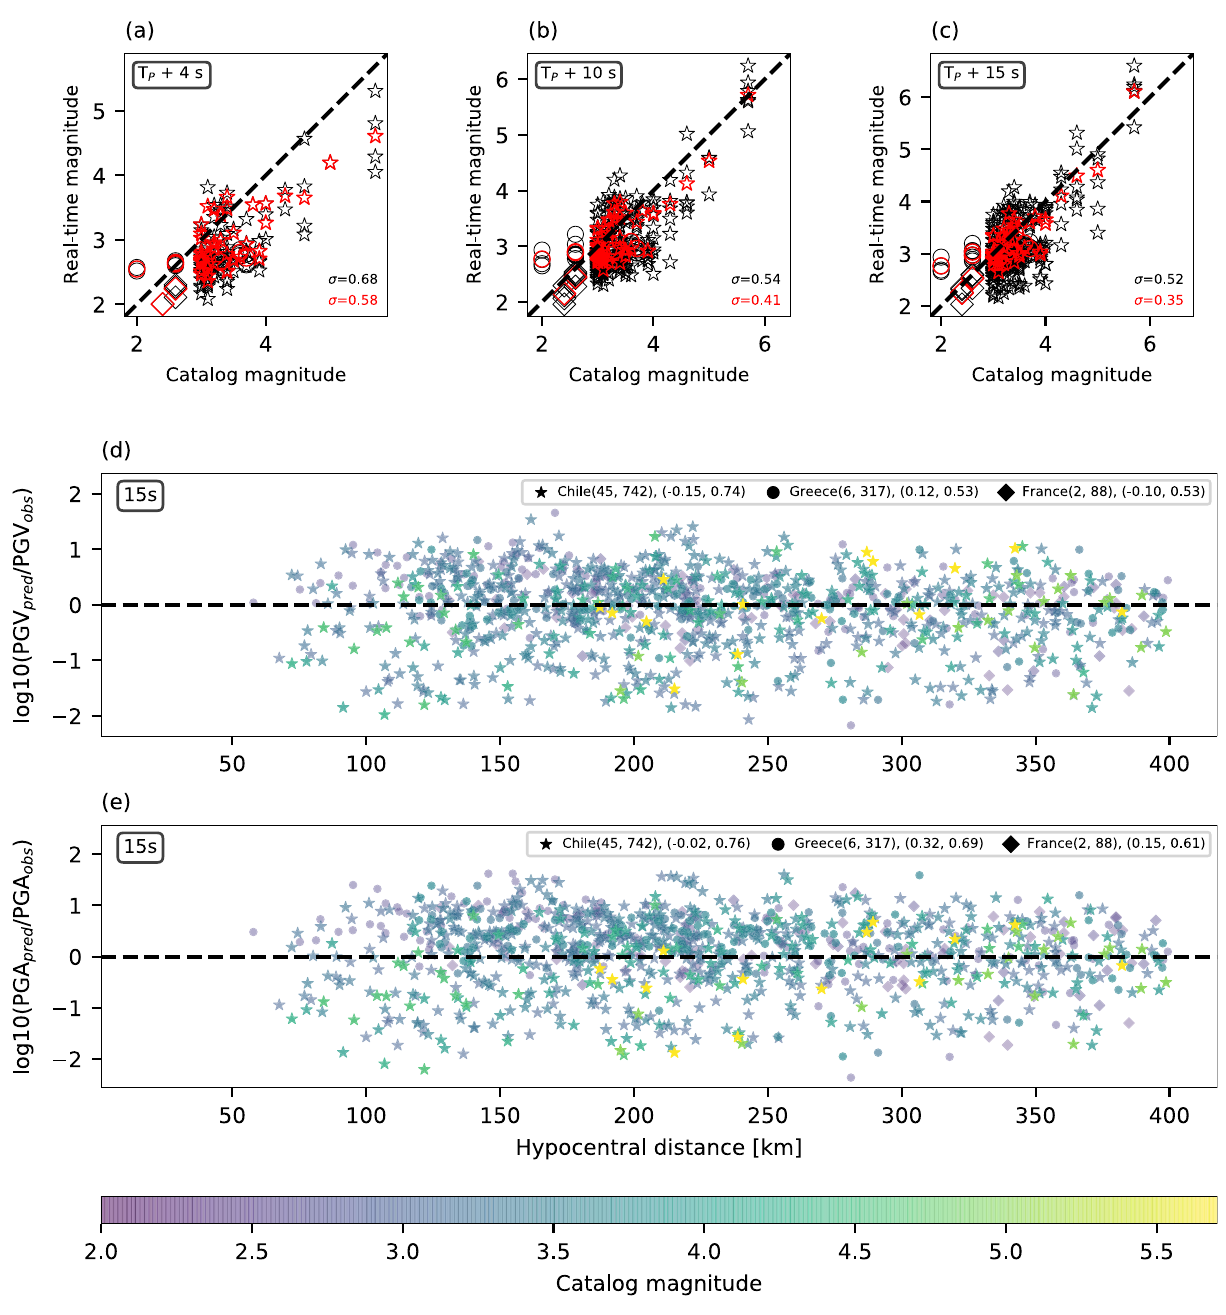
Figure 4. Real-time magnitude estimation and ground motion prediction using 10 MPa. Real-time magnitude as a function of catalog magnitude at a 4, b 10 and c 15 s from the P-wave arrival at the first fiber segment. Fiber- segment-specific estimates and event averages are indicated by black and red symbols, respectively. The dashed black line is a 1:1 line and the standard deviations of the magnitude residuals are indicated in the bottom right corners for segment specific (black) and event averaged (red) estimates. Discrepancies between the logarithms of predicted and observed peak ground motions are plotted for d PGV and e PGA as functions of hypocentral distance. Color-code corresponds to catalog magnitudes. Earthquakes from Chile, Greece and France are indicated by stars, circles and triangles, respectively. Panel legends indicate the following: cable name (number of earthquakes, number of PGV and PGA observations), (average residuals, standard deviation to the residuals). Average within event variabilities, i.e., the optimal standard deviation to the residuals, for PGV are 0.68, 0.5 and 0.52 for Chile, Greece and France, respectively, and for PGA are 0.71, 0.61 and 0.59 for Chile, Greece and France,